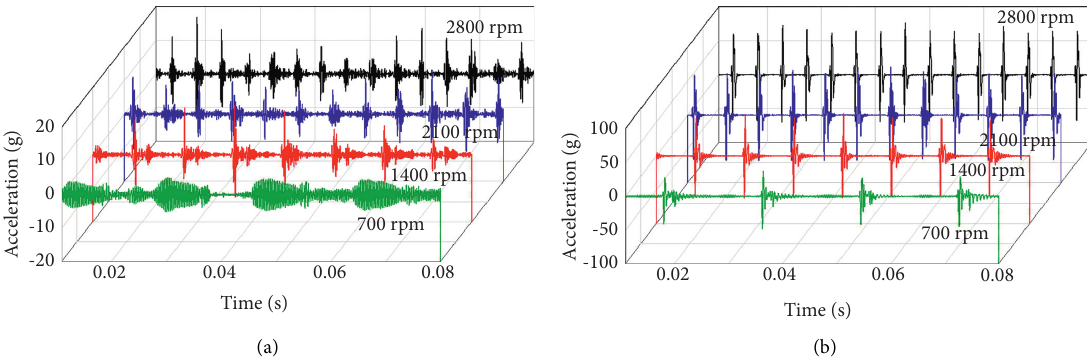
Figure 13: Acceleration signals under different speeds at different points: (a) the measurement point #8 and (b) the defect point #0.